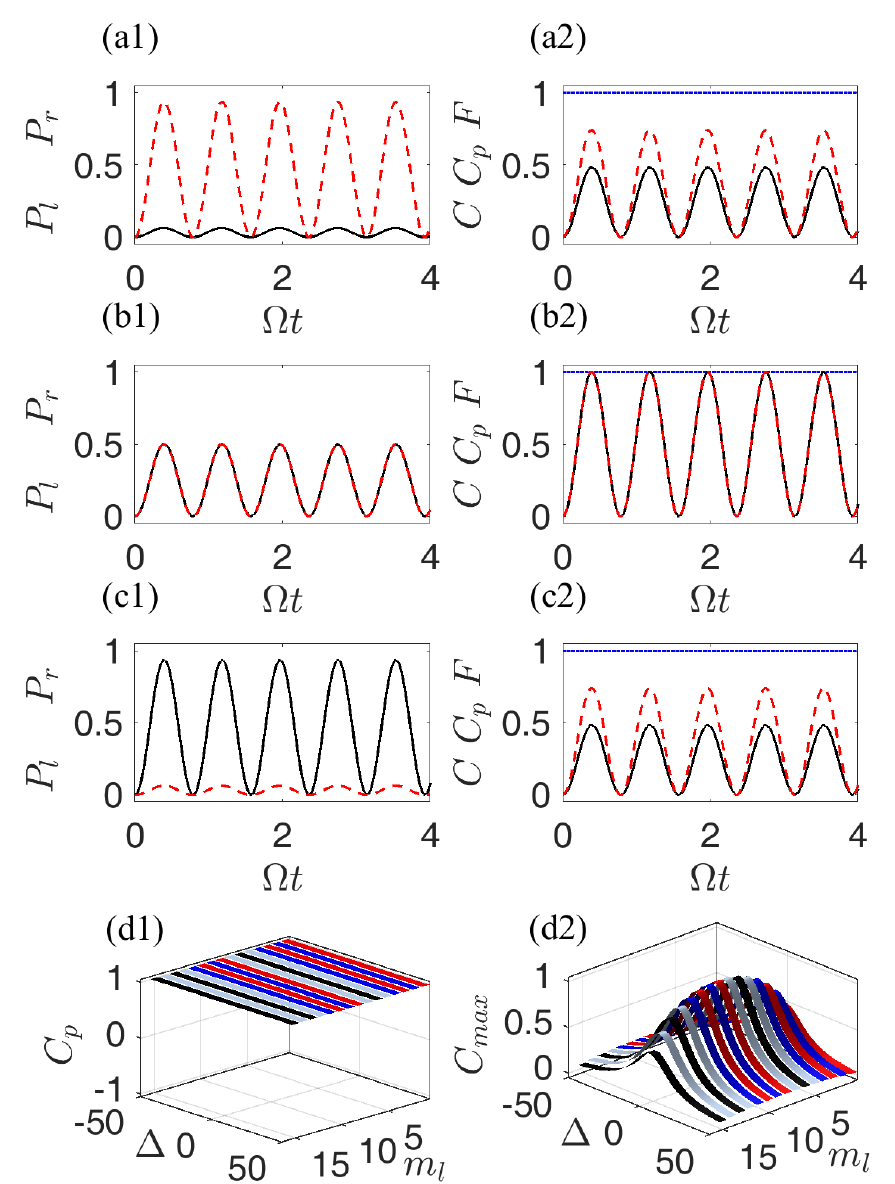
Figure 3. Calculated dynamics for an initial state of | G l (cid:105)| G r (cid:105) . ( Left ): time evolutions of collective Rydberg excitation probabilities P l (solid black curve) and P r (dashed red curve); ( right ): of the concurrence C (solid black curve), the Pearson correlation coefficient C p (dotted blue curve), and the fidelity F + ( t ) = |(cid:104) ψ ( t ) | ψ + (cid:105)| 2 (dashed red curve) with | ψ + (cid:105) = 1 √ of parameters ( a1 , a2 ): ( m l , m r , ∆ ) = (1,15,0); ( b1 , b2 ): ( m l , m r , ∆ ) = (8,8,0); ( c1 , c2 ): ( m l , m r , ∆ ) = (15,1,0). Pearson correlation coefficient C p ( d1 ) and the maximal concurrence C max ( d2 ) as a function of the single-photon detuning ∆ and the number of atoms m l in the left subsuperatom for the evolution time Ω t = 4. The total atom number m = 16 remains unchanged. Other parameters are given at the beginning of Section